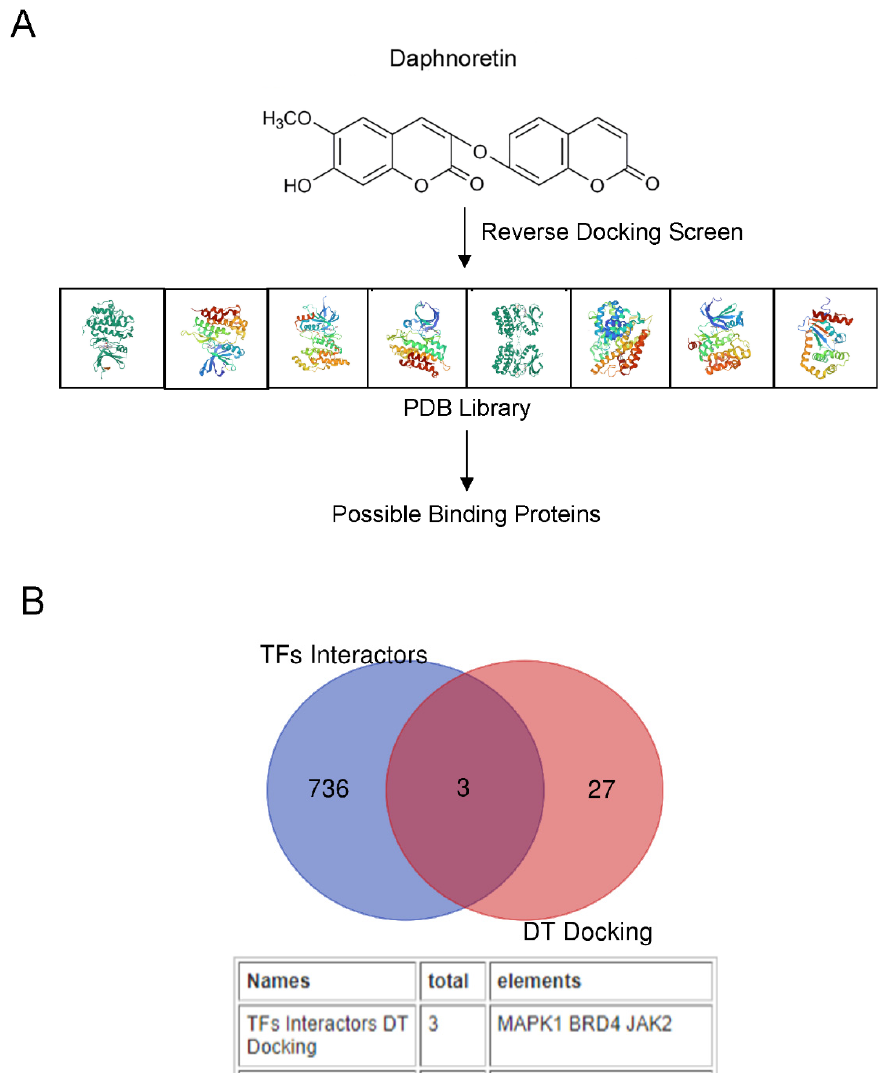
Figure 4. Prediction of DT possible protein targets. Scheme of DT reverse docking screen flow ( A ). Venn diagram showing protein overlap between predicted DT reverse docking proteins and predicted DT-activated TF binding proteins ( B ).